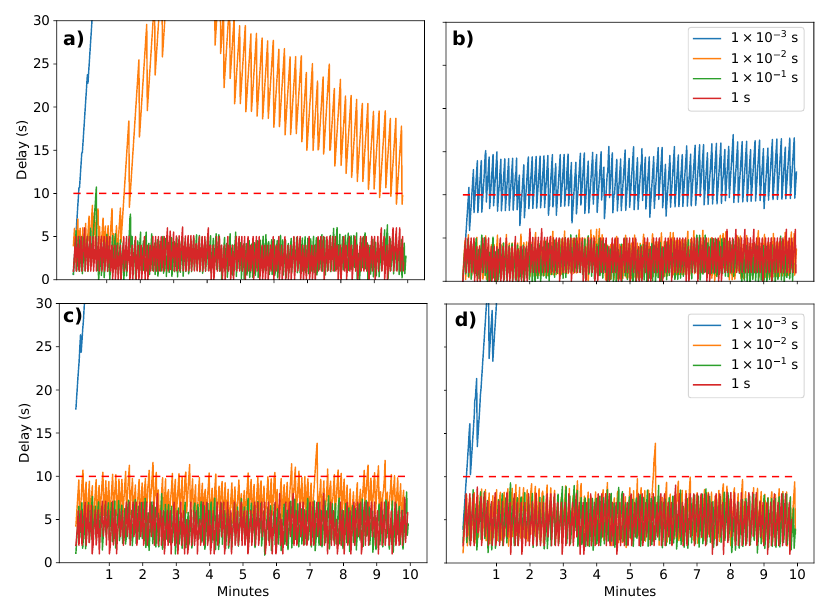
Figure 3. Disk usage versus number of monitored instruments in a single DAQBroker server on a LP machine ( a) and c) and a HP machine ( b) and d) . The top plots ( a) and b) show writes per second and the bottom plots show reads per second ( c) and d) . Figure 4. Current to stored timestamp di ff erences versus time for di ff erent machines and data genera- tion periods. The left plots ( a) and c) show the LP machine performance and the right plots ( b) and d) show the HP machine performance. The top plots ( a) and b) show the use of a local database engine while the bottom plots ( c) and d) show the use of a remote database